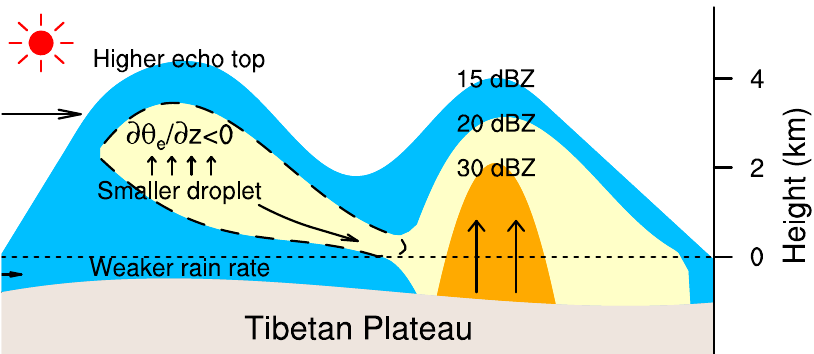
Fig. 4 Conceptual diagram of a ghost echo over the Tibetan Plateau. The ghost echo is on the left, and normal convection is on the right. The height is the difference between the actual altitude and the freezing